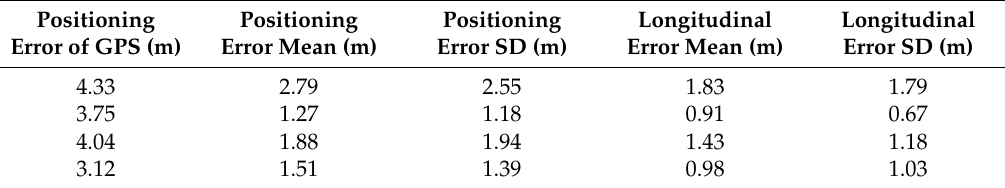
Figure 13. Errors of vehicle localization. Table 3. Localization errors from different values of GPS errors.